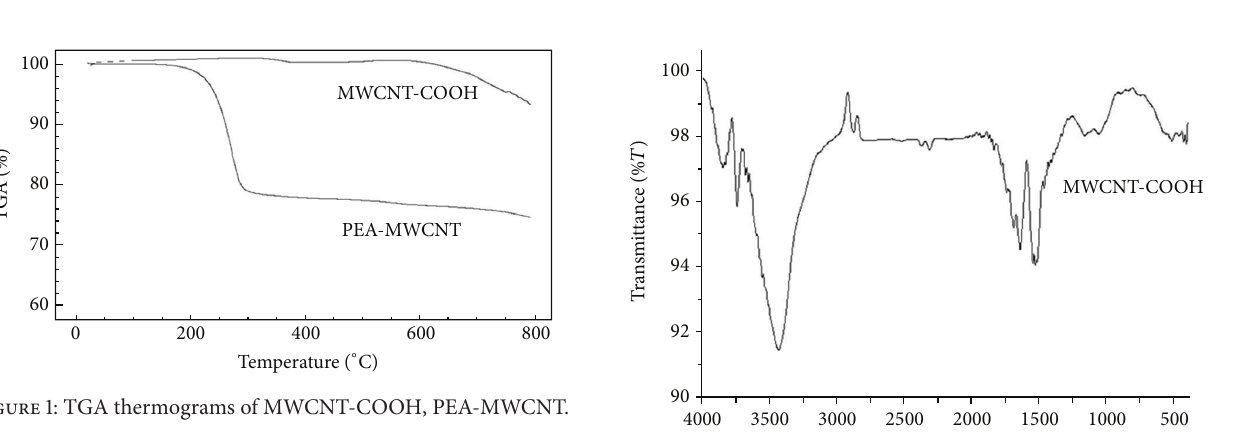
Scheme 1: Composite synthesis.